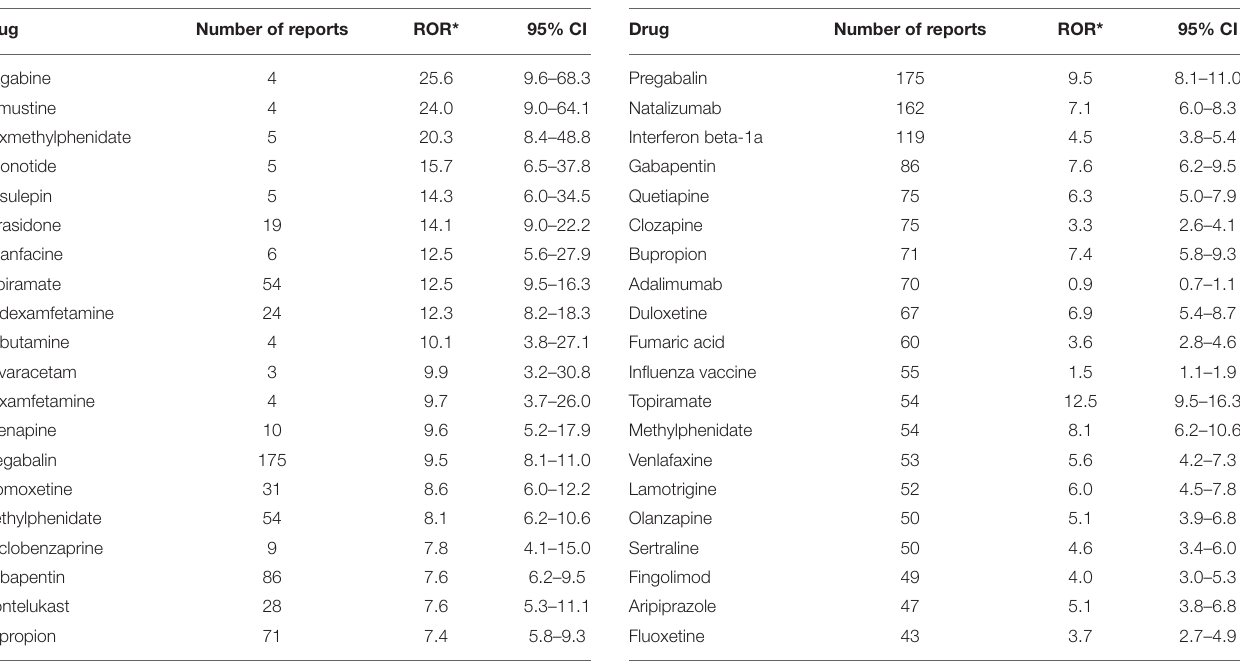
TABLE 2 | Top 20 drugs at the fifth ATC level ranked according to the highest number of reports in VigiBase; the ROR is given as well.